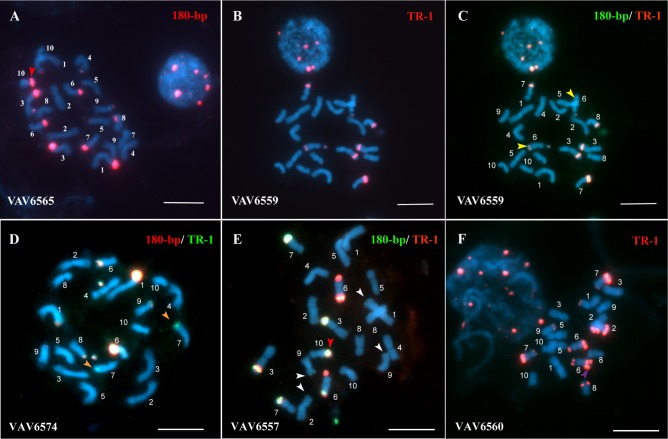
Characterization of Floury Guaraní maize metaphase chromosomes by FISH with knobs probes.(A-F) merge DAPI (blue) / FISH. (A) VAV6565, Rosado. (B) and (C) VAV6569, Overo. (D) VAV6574, Blanco Angosto. (E) VAV6557, Variegado. (F) VAV6560, Blanco Ancho. The probes were labeled with digoxigenin and biotin, and revealed with antidigoxigenin-FITC (green) and Cy3 (red), respectively. Ref. The red arrowhead indicates a chromosome with AB10 morphology. The yellow arrowheads show heterozygosis for the 6L knob chromosome position. The white arrowhead indicates knobs hybridized only with 180-bp sequence. The orange arrowhead indicates knobs hybridized only with TR-1 sequence. The numbers indicates the chromosomal pairs. Scale bars = 10 μm.